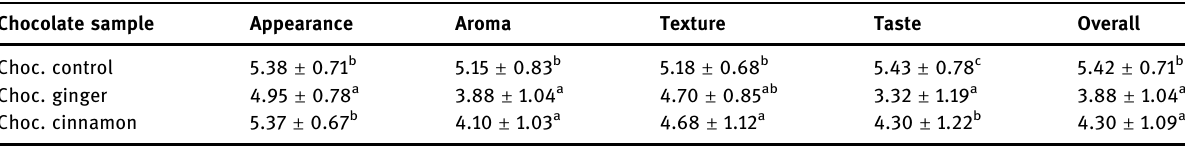
Table 1: Panelists ’ hedonic response of chocolate bars formulated with ginger and cinnamon Chocolate sample Appearance Aroma